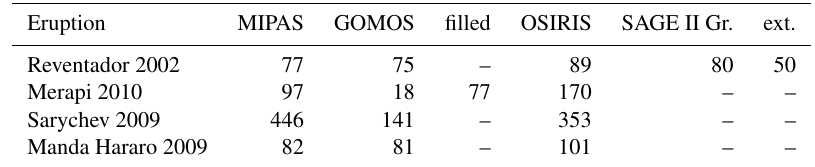
Table B1. Integrated mass of injected SO 2 (kt) for the different methods in Figs. B1 to B3. Eruption MIPAS GOMOS filled OSIRIS SAGE II Gr.